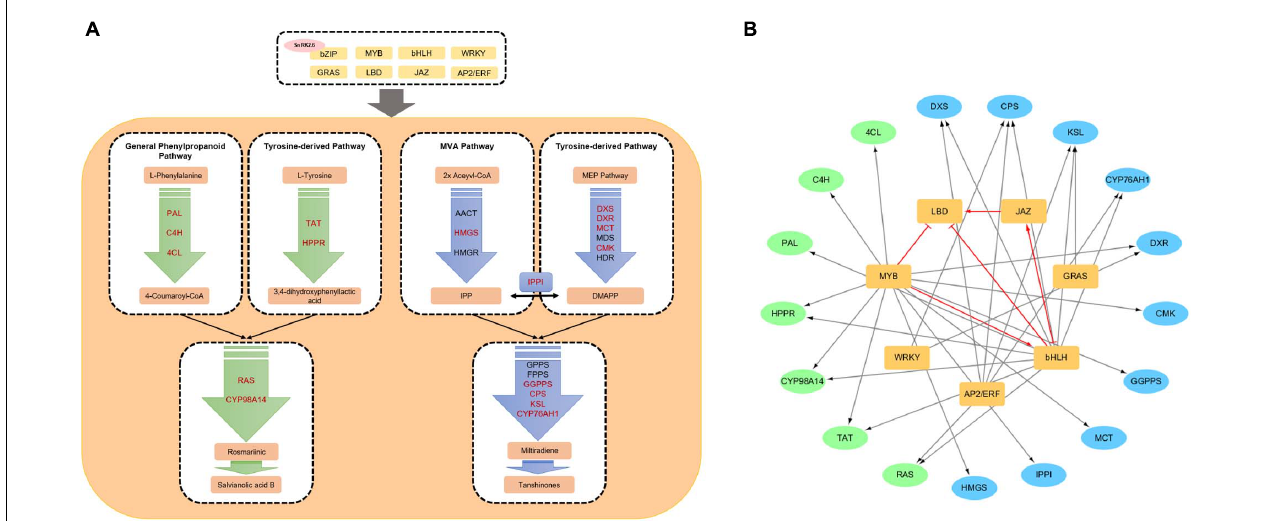
FIGURE 1 | Biosynthetic pathways and a transcriptional regulation network of ingredients in Salvia miltiorrhiza . (A) A simplified transcriptional regulation network of phenolic acid and tanshinone biosynthetic pathways. Red enzyme genes can be interacted with transcription factors. (B) The transcription factor–enzyme gene regulation network. The black arrows indicate the interaction between TFs and enzyme. Red arrows and red T-shaped line indicate upregulation and inhibition between transcription